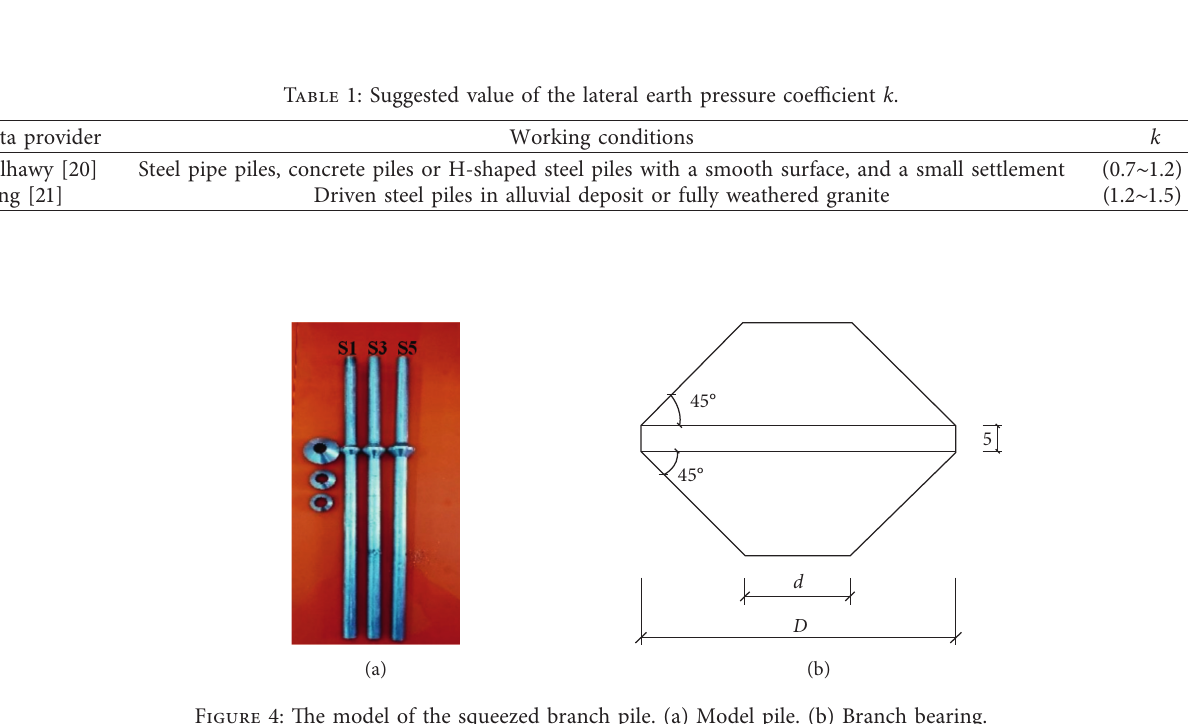
Figure 3: The calculation of the bearing capacity of the squeezed branch pile.